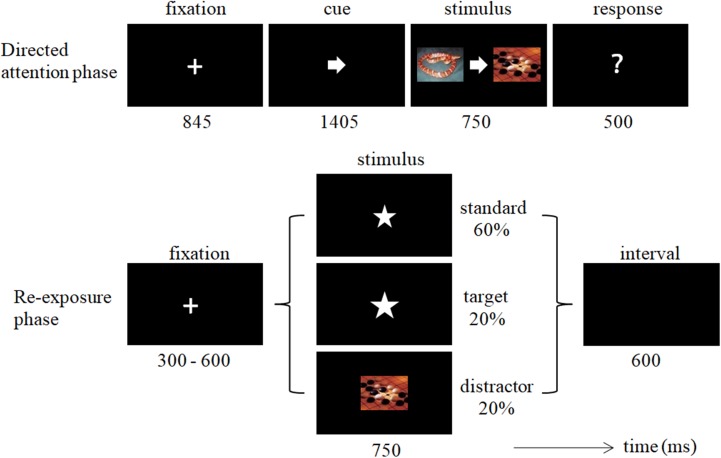
Illustration of experimental trials during the directed attention phase and re-exposure phase.